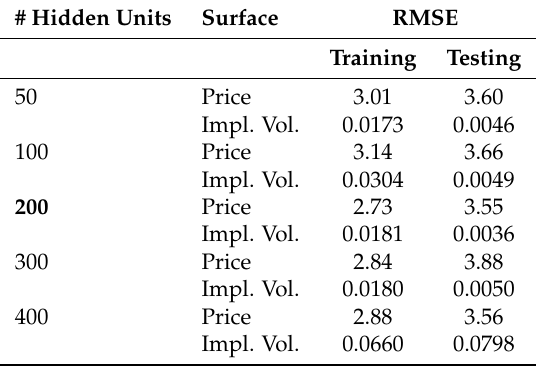
Figure 9. Logarithmic RMSE through epochs ( top ) hard constraints ( bottom ) dense networks with soft constraints. Table 5. Sensitivity of the errors to the number of hidden units. Note that these results are generated using the dense network with soft constraints and Dupire